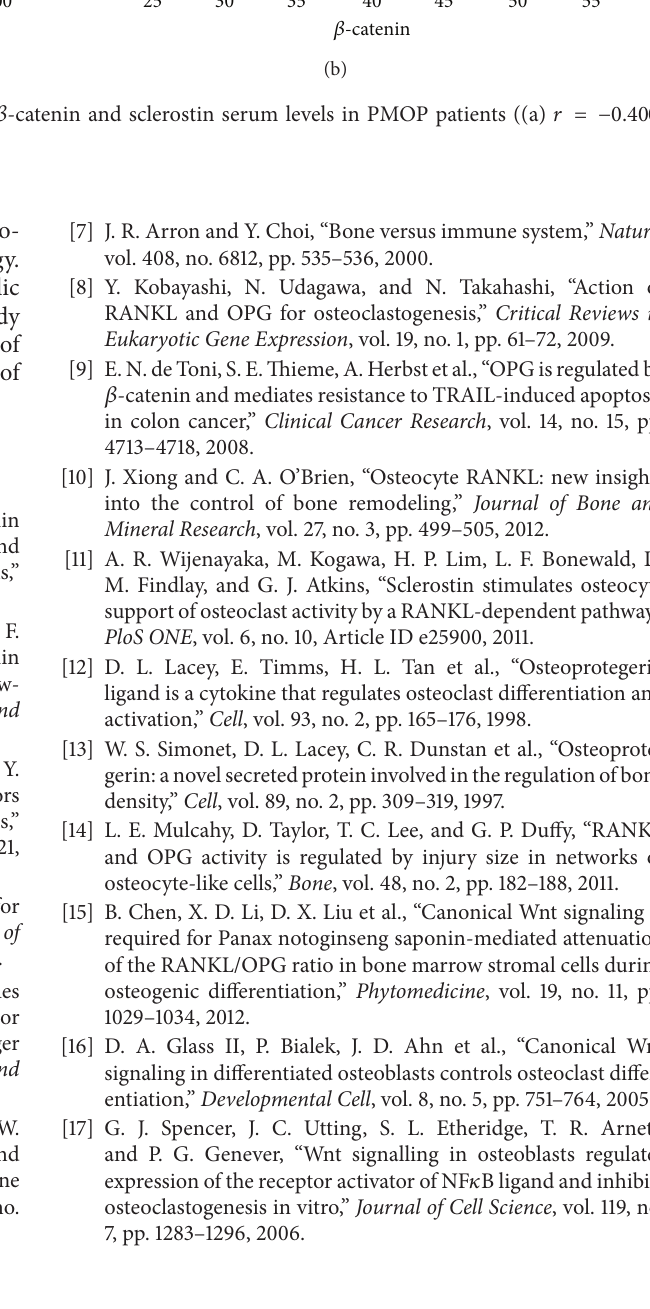
Figure 4: Univariate correlation (Spearman analysis) between 𝛽 -catenin and sclerostin serum levels in PMOP patients ((a) 𝑟 = −0.400 , 𝑃 < 0.001 ) and controls ((b) 𝑟 = 0.145 , 𝑃 = 0.060 ).